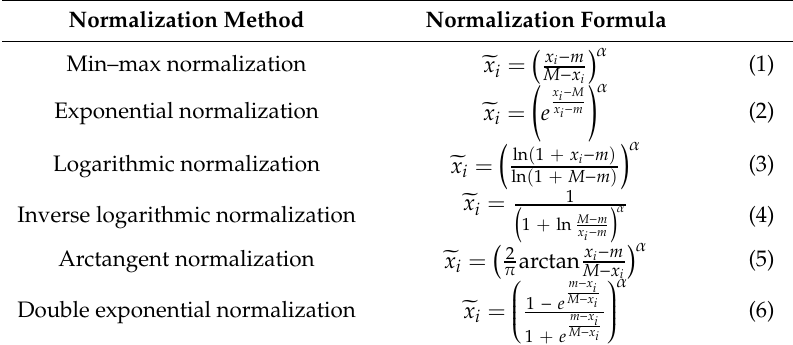
Table 2. Formulas for six classes of direct normalization